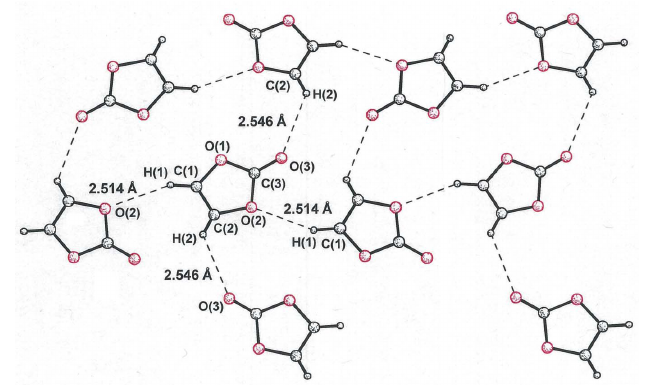
Figure 6 Ball and stick representation of the sheetlike arrangement in 2a , where molecules (left-to-right) are related by a glide-plane operation rather than simple translation. Closest intermolecular contacts are illustrated.